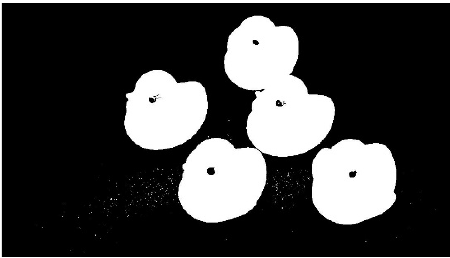
Figure 7. Binarization result of gray image M .